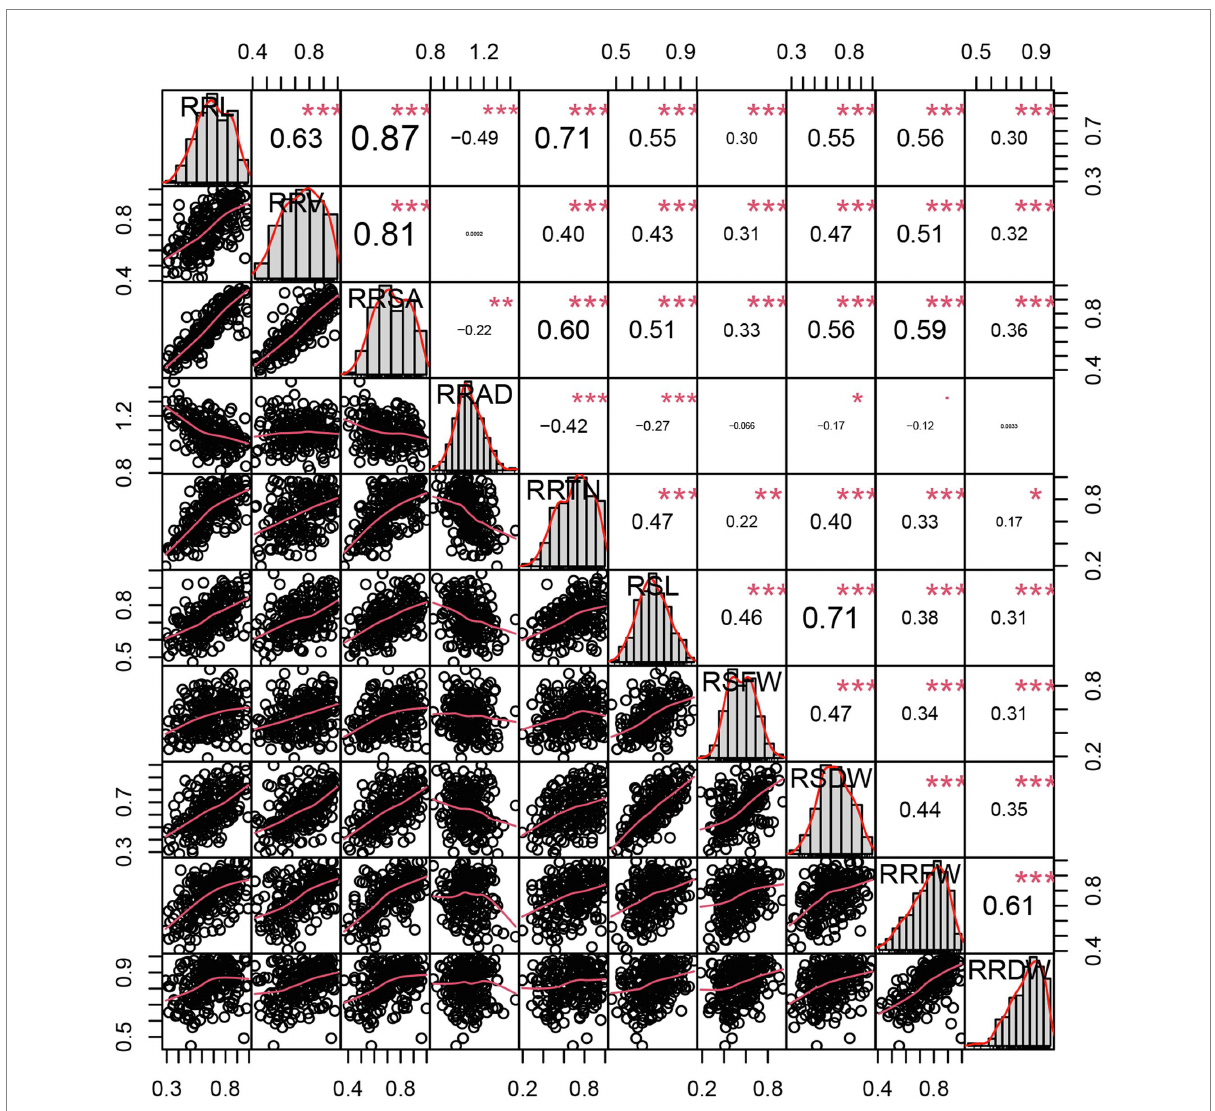
FIGURE 2 Distributions of and correlations between 10 relative phenotypic traits. The frequency distribution histograms of 10 traits are located on the diagonal line, the area below the diagonal line is the scatter plot of the traits, and the area above is the correlation coefficient between each pair of traits. *, **, and *** indicate significance at p < 0.05, p < 0.01, and p < 0.001,